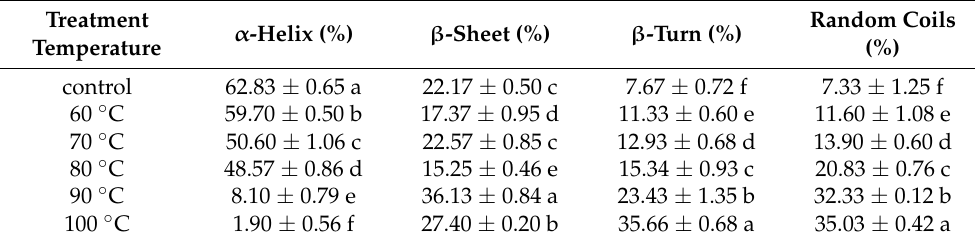
Table 1. Percentage of secondary structure of the northern pike liver ferritin at different temperatures (untreated, 60, 70, 80, 90, and 100 ◦